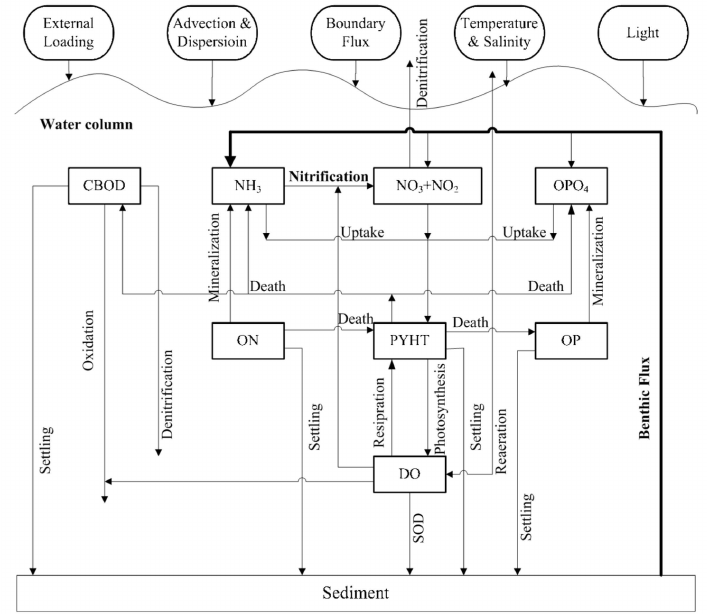
Figure 2. Schematic of water quality